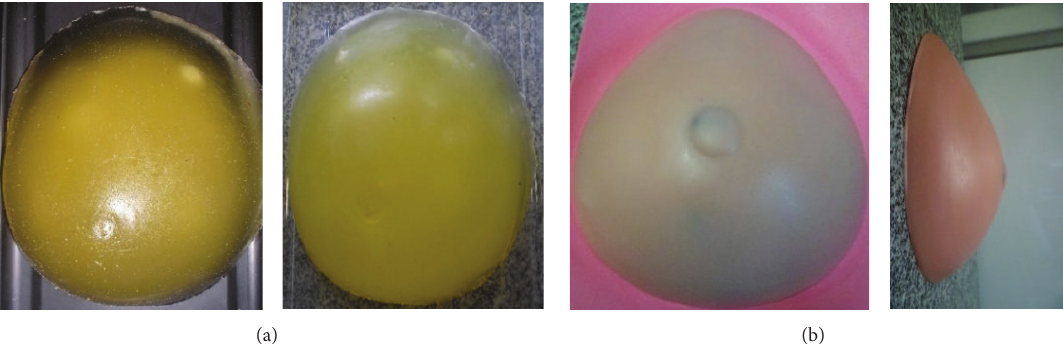
Figure 1: Breast biopsy phantoms designed for ultrasound images: (a) BB-1 model from ATS Laboratories and (b) models developed by Vieira et al.